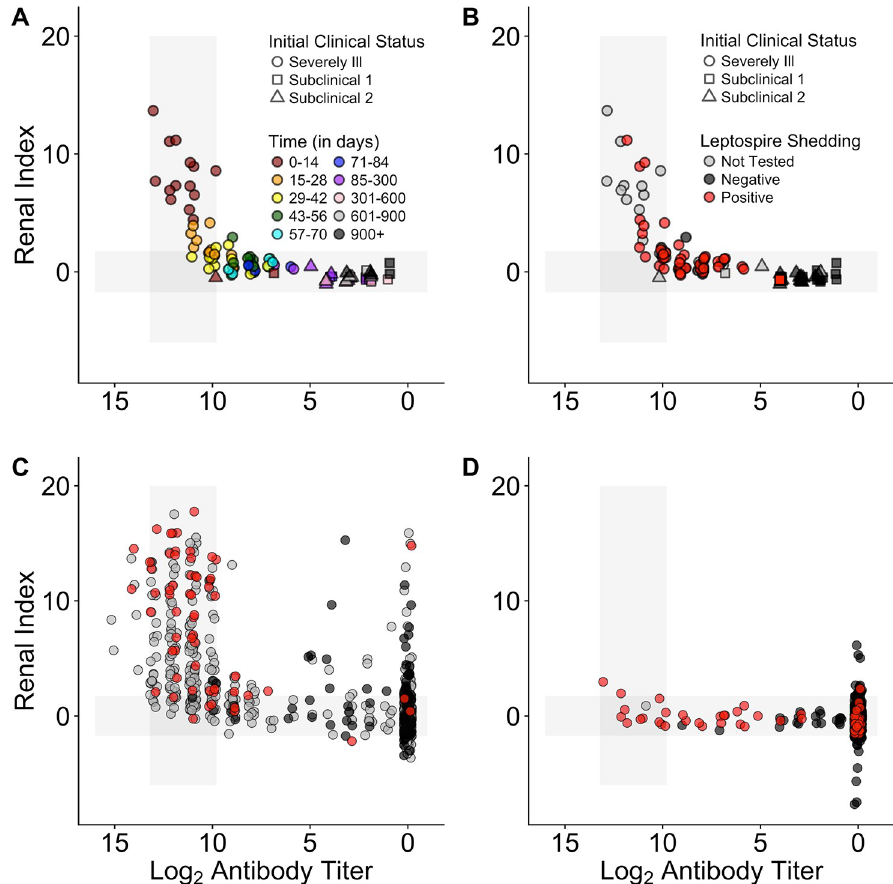
Fig 4. Map of host-pathogen space. Maps of the host-pathogen space created by plotting jittered log 2 anti- Leptospira antibody titers (x-axis) against renal index values (y-axis). Plots created using data from the longitudinally followed animals (CLINICAL and SUBCLINICAL), color-coded by time since admission to a rehabilitation center (A) and by urinary leptospire shedding status (B). Plots created using cross-sectional data from stranded animals (STRAND; C) and wild-caught, free-ranging animals (WILD; D) color-coded by urinary leptospire shedding status. In all panels, horizontal grey bands are equivalent to those in Fig 1C & 1D, and the vertical grey bands are equivalent to the horizontal bands described in Fig 1A &